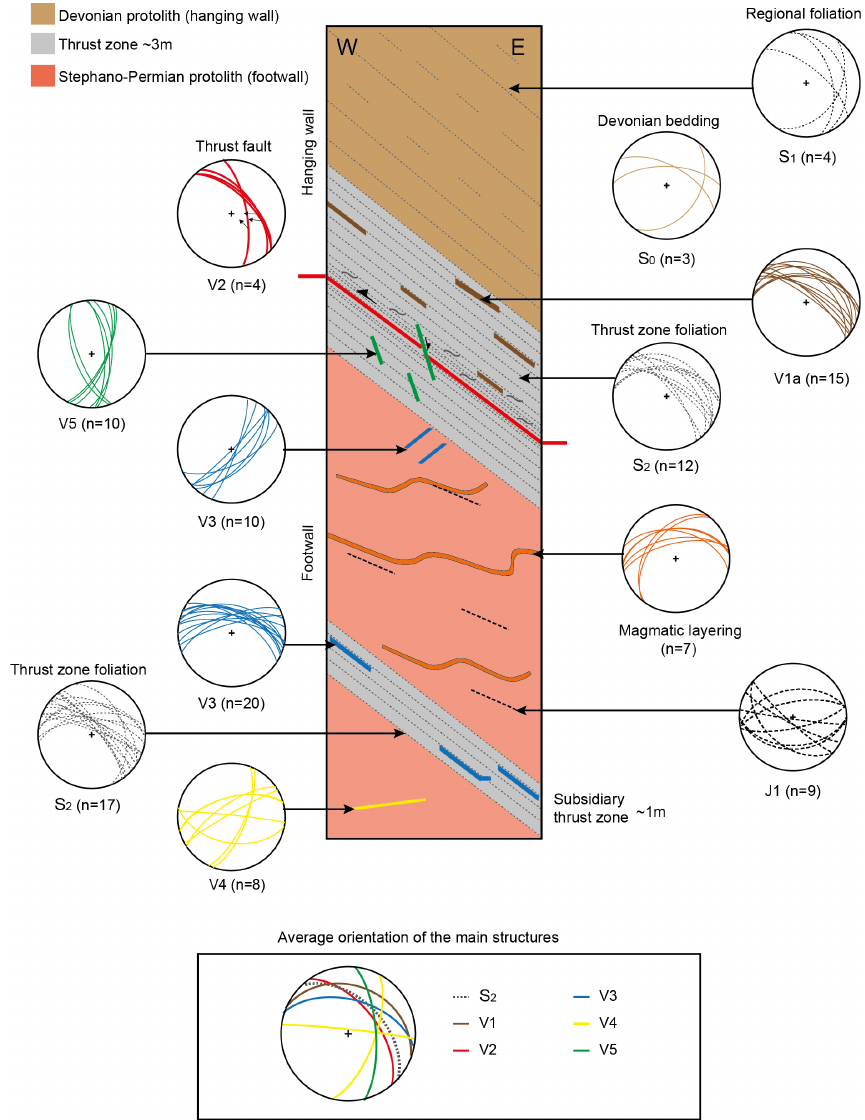
Figure 3. Sketch showing the spatial distribution of mesoscale structures within the main outcrop and lower-hemisphere equal-area stereo- plots of the different mesostructures. The average orientation of the main structures is also